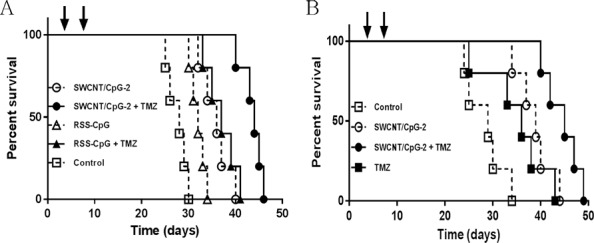
Anti-tumoral efficacy of SWCNT/CpG-2 in the invasive K-Luc glioma model.(A and B) Four and eight days (indicated by black arrows) after i.c. tumor implantation, mice received intratumoral (i.t.) injections of SWCNT/CpG-2, RSS-CpG or PBS. TMZ (2.5 mg/kg) was administered daily beginning on day 4. Kaplan–Meier analysis showed SWCNT/CpG-2+TMZ significantly extended survival relative to all other treatment groups (curves significantly different P < 0.0001 by Log-rank test, n = 5).